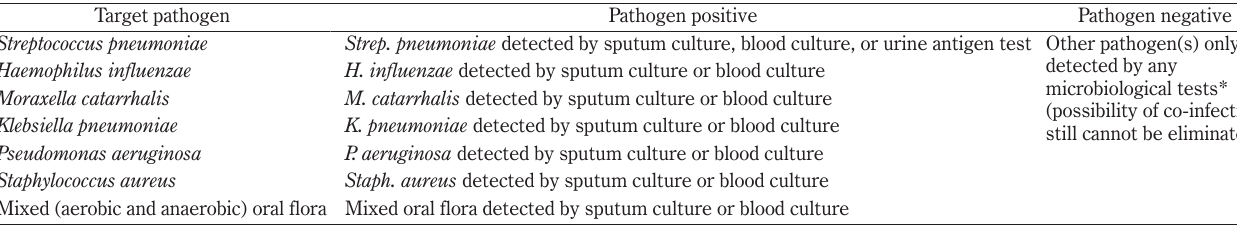
Table 2 Operational definitions of target pathogen positive and negative by clinical reference standards Target